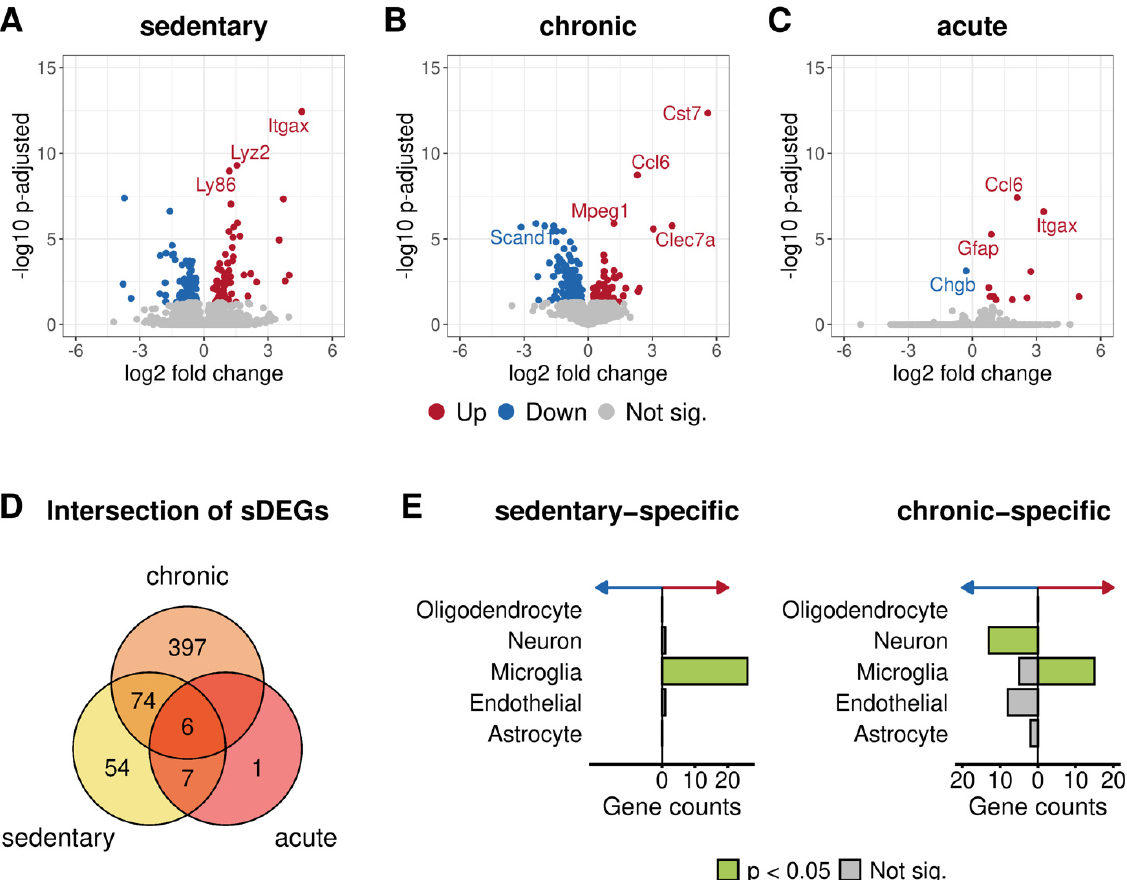
Figure 7. Differential expression analysis results of 5xFAD compared to wild-type mice at different levels of physical activity. The volcano plots in A–C visualize the negative log10 of the adjusted p -value and the corresponding log2-fold change of the differential expression analyses between ( A ) sedentary 5xFAD vs. wild-type mice, ( B ) chronically trained 5xFAD vs. wild-type mice, and ( C ) acutely trained 5xFAD vs. wild-type mice. Each group consisted of four samples. Positive and negative log2-fold change values correspond to up- and downregulated genes in 5xFAD mice at the respective level of physical activity. Differentially expressed genes with an adjusted p -value < 0.05 are colored in red or blue, corresponding to up- or downregulation. The five most significant genes are labeled by their gene symbols. All non-significant genes are colored gray. ( D ) shows the intersection of the DEGs found in each comparison. Empty fields represent a zero overlap. ( E ) shows the cell type enrichment results for the sedentary-specific (left) and chronic-specific DEGs (right) while the right and left bars correspond to upregulated and downregulated genes represented by the direction of the red and blue arrows. Green bars visualize significantly enriched cell-types, while gray represents no significance.